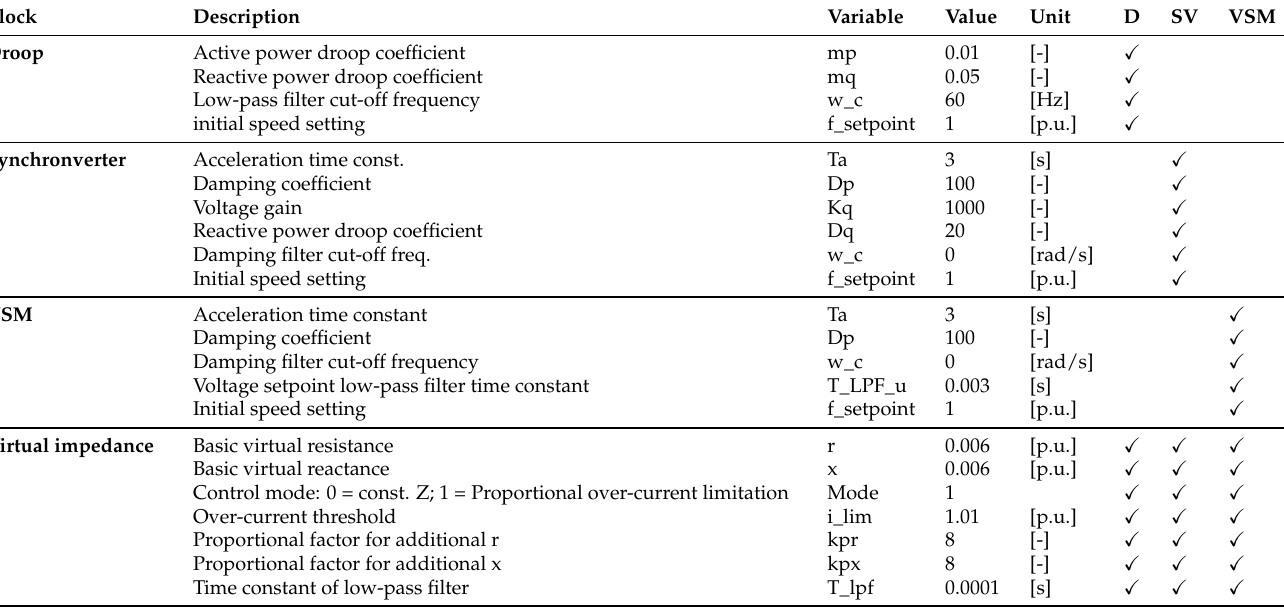
Table A1. The tuning constants implemented in the grid-forming control in the DSL modules from the PowerFactory